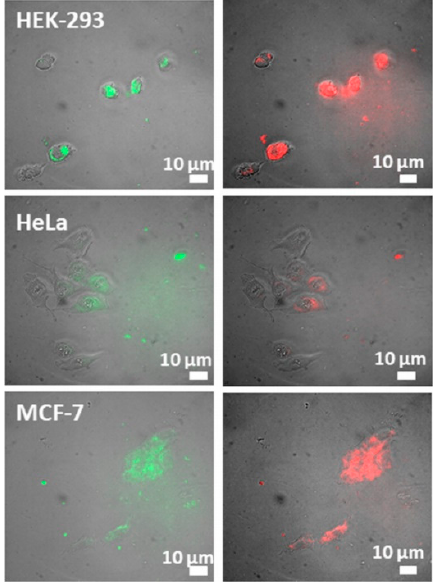
Figure 8. Pictures representing the GO-SPIONs green (550 nm) as well as red (635 nm) fluorescent